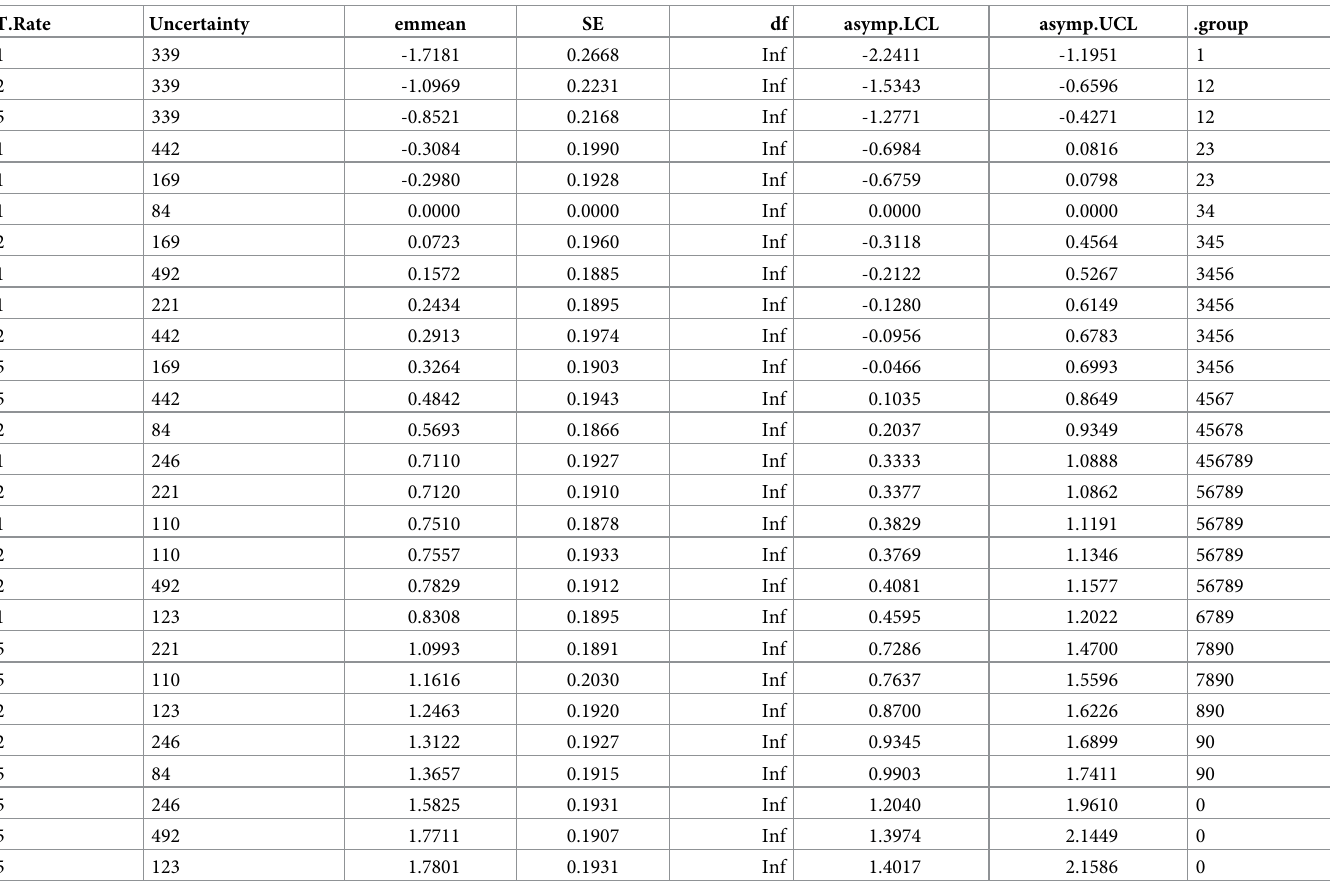
Table 6. Estimated marginal means and compact letter display for all-pairwise comparisons of the interaction between masker-target similarity and masker uncer- tainty in Experiment III.